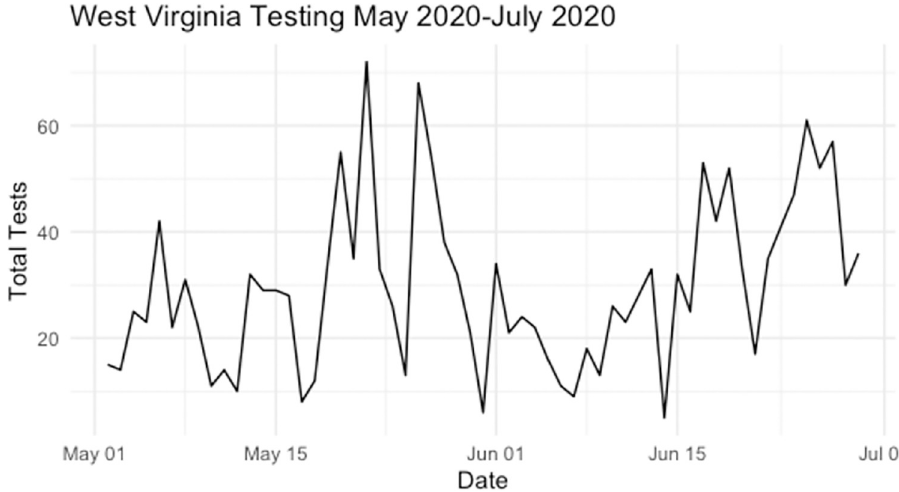
Fig 3. Number of SARS-COV-2 tests in the state West Virginia from May 2020- July 2020.